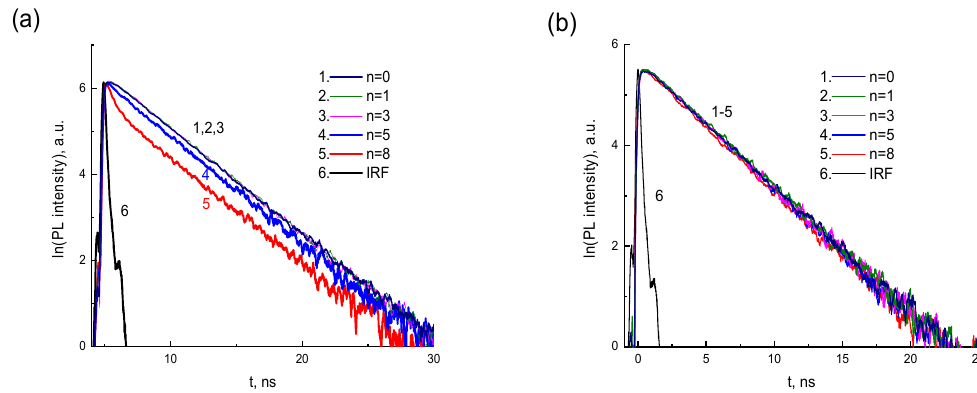
Figure 7. ( a ) Absorption spectra of the aqueous solution of 2416SL (5 · 10 − 5 M) (1), initial dispersion of CdTe QDs ( d = 2.5 nm) (2), the mixture of CdTe-2416SL at n = 15 (3,4) in the form of supernatant (nanoaggregates precipitated) (3) and freshly mixed having nanoaggregates in the dispersion (4). Differential spectrum, ∆ , (5) obtained by subtraction of the spectrum (3) from the spectrum (4). ( b ) PL quenching dynamics for the aqueous solution of 2416SL (5 · 10 − 5 M) with fresh admixing of CdTe QDs ( d = 2.5 nm) dispersions at n = 0 (1), n = 3 (2), n = 9 (3), n = 15 (4,5); λ e = 385 (1–4) and 510 (5) nm. ( c , d ) PL spectra for (supernatant) mixtures of CdTe-2416SL at n = 8 for CdTe QDs with d = 3.5 nm (1) and 2.5 (2) nm; λ e = 385 ( c ) and 510 nm ( d ). T = 296 K.